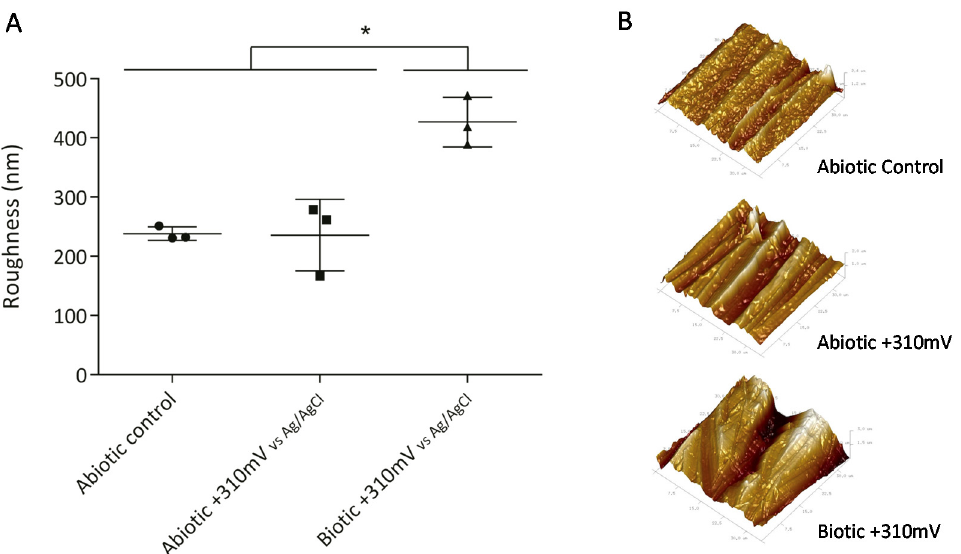
Figure 3. Roughness of SS electrodes (second experiment), measured by atomic force microscopy (AFM). Asterisks represent significant differences between treatments ( P < 0.05). ( A ) Average roughness of SS electrodes with standard deviation and ( B ) 3D Atomic Force Microscope (AFM) images of SS electrodes obtained over an area of 35 µm × 35 µm.